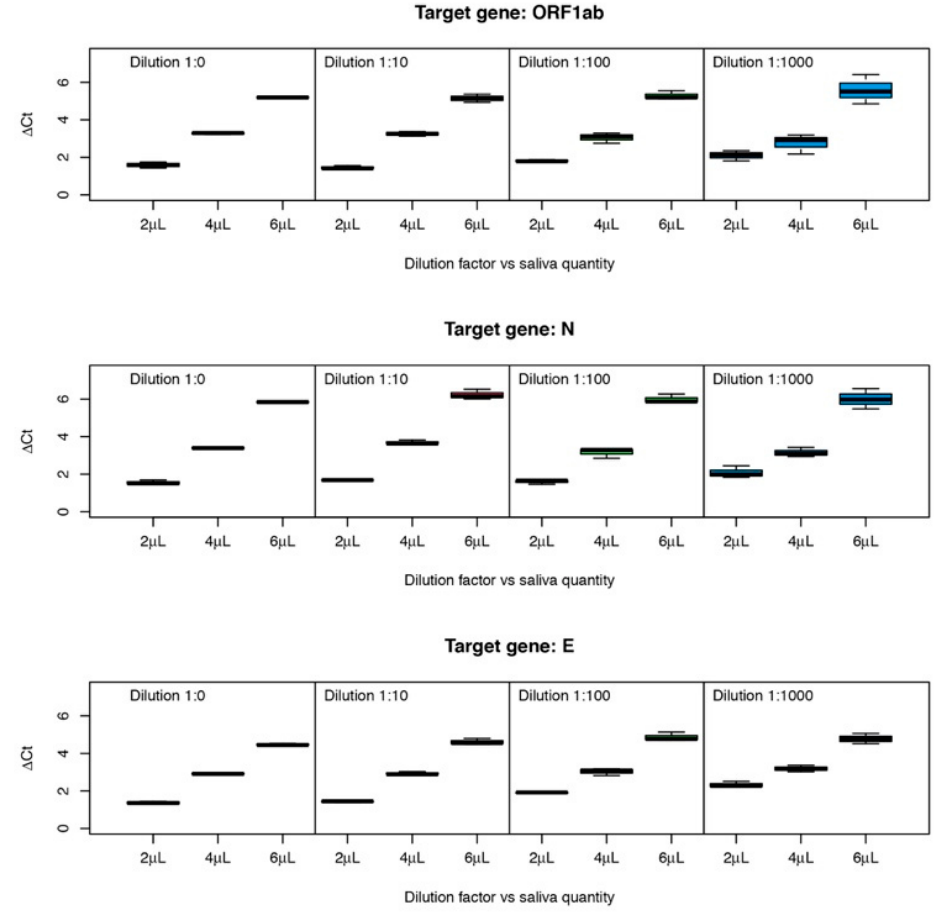
Figure 3. ∆ Ct values obtained for RT-PCR reactions using different amounts of saliva and initial viral RNA concentrations.